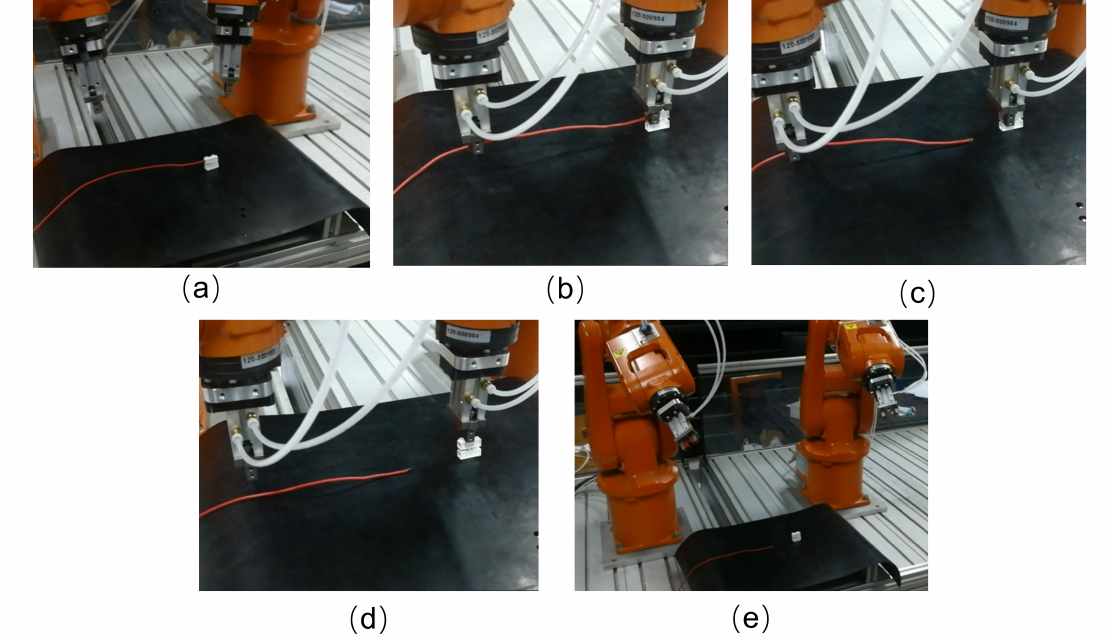
Figure 16. Perform tasks in real robot scene. ( a ) Dual-robot approaches grasping points. ( b ) Dual- robot grabs object. ( c ) Left robot pulls out the wire. ( d ) Dual-robot puts down the object. ( e ) Dual-robot returns to the